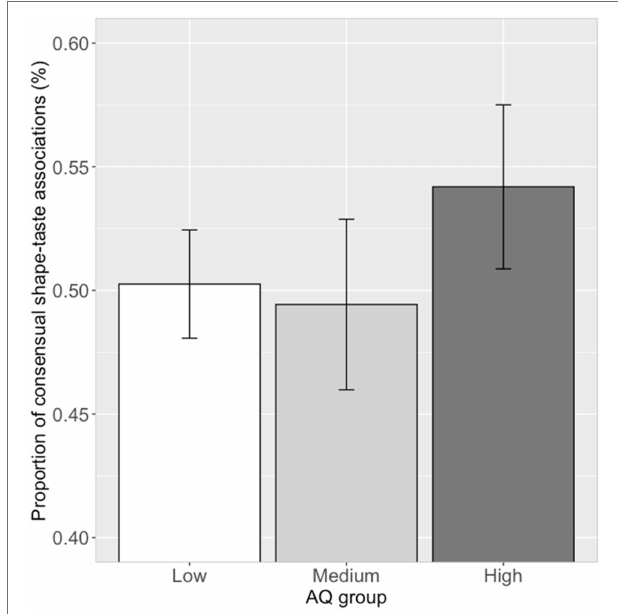
FIGURE 6 | Proportion of consensual shape–taste associations in the three AQ groups. Error bar represents the standard mean error.